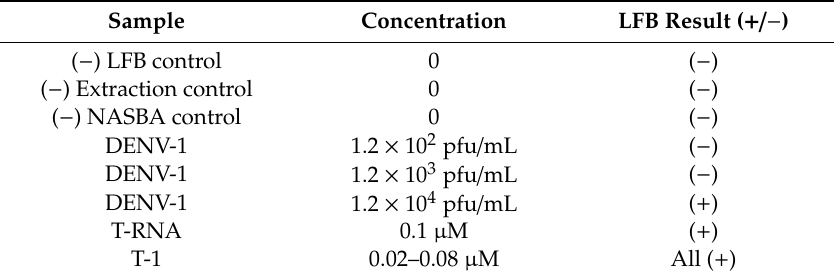
Table 2. Summary of detection of DENV-1 in aqueous